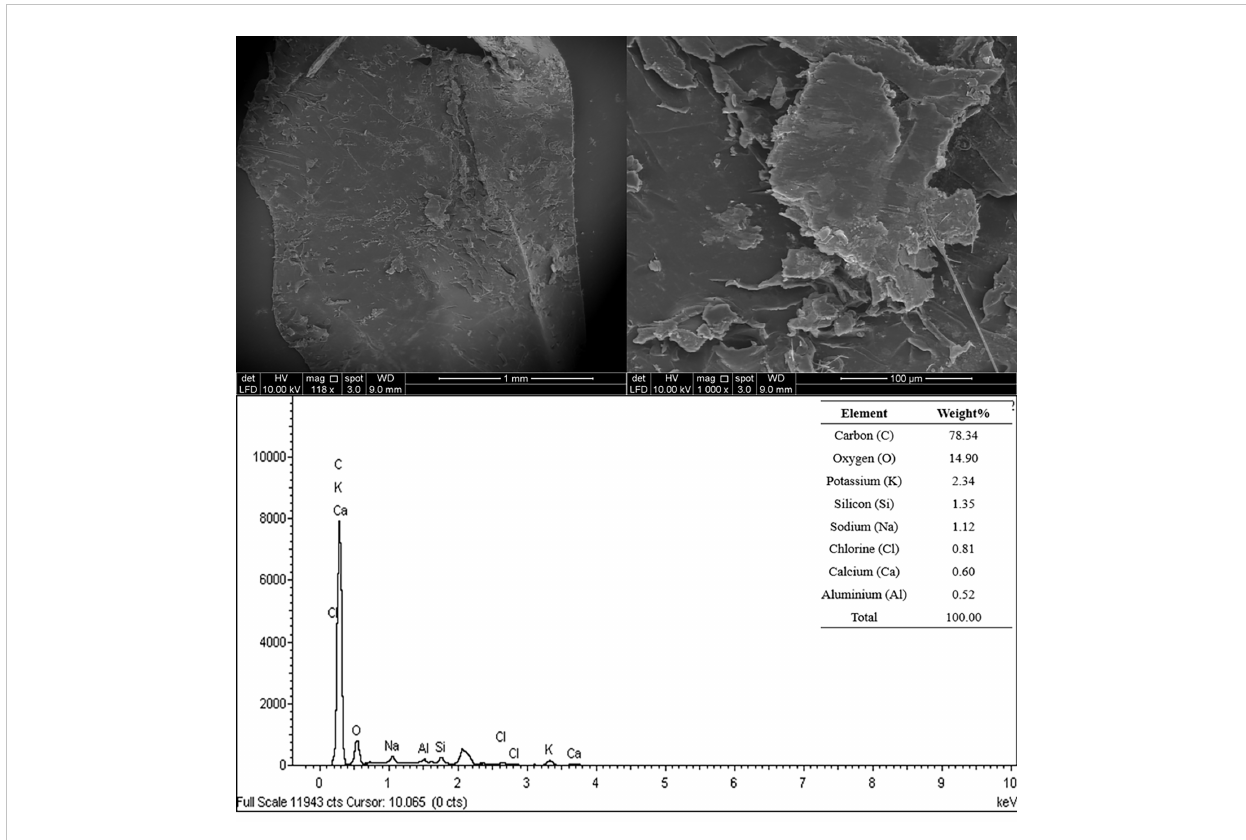
FIGURE 8 FESEM images of aged fi lm and the corresponding EDX spectra of aged fi lm recovered from the estuarine environment of